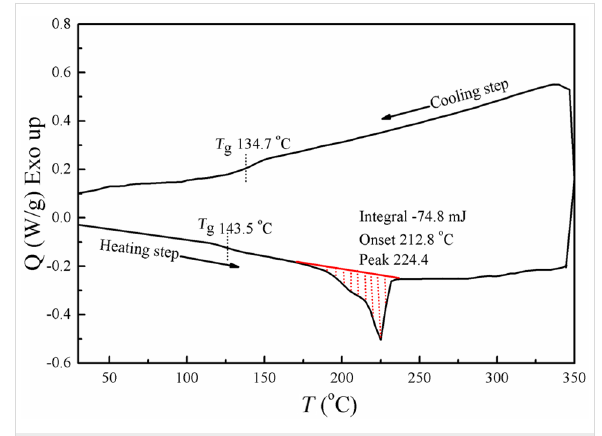
Figure 6: DSC profile of the PC/MWCNT film at 1 wt % loading.